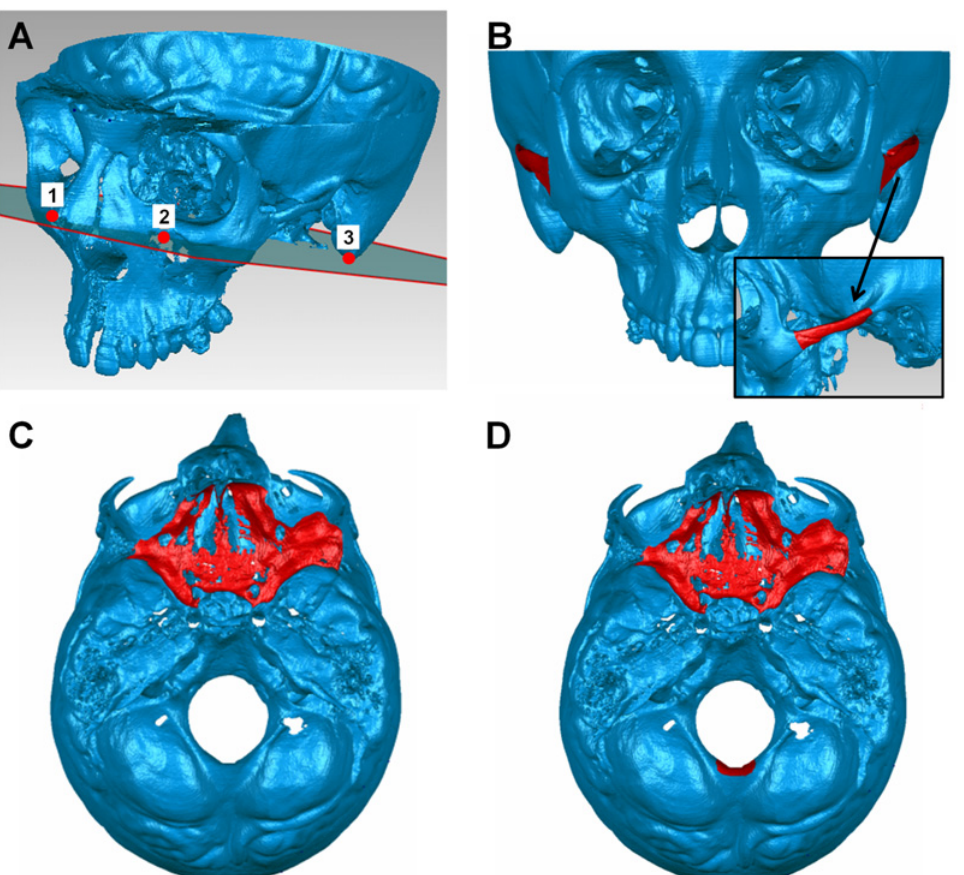
Fig 1. Reference points/structures used for each superimposition technique. (A) Points used for the three-point registration technique (numbered red dots): the most superior point of the infraorbital foramen on the left and right side and the lowest point of the mastoid process on the left side. (B) The used part of the zygomatic arch (red color) extended from the most anterior point of the zygomaticomaxillary suture to the junction of the arch with the main part of the temporal bone. (C) The used part of the anterior cranial base (red color) included the body and small wing of the sphenoid bone and part of the bottom of the anterior cranial fossa (the sella turcica, the orbital upper wall, the sinuses upper walls, and the cribriform plate and crista galli of the ethmoid bone were not included). (D) The used part of the foramen magnum included the middle posterior part of the edge of the foramen magnum with the posterior cranial fossa, having approximately a height of 1 cm and a width of 1.5 cm (red color).